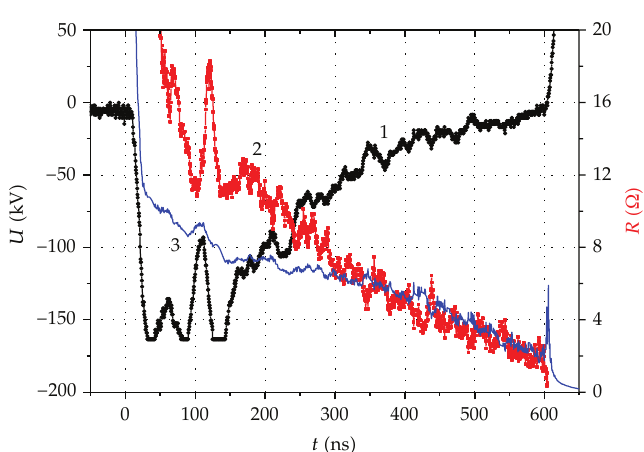
Figure 10: Waveforms of (cid:2) 1 (cid:3) voltage, (cid:2) 2 (cid:3) experimental, and (cid:2) 3 (cid:3) calculated impedance values.